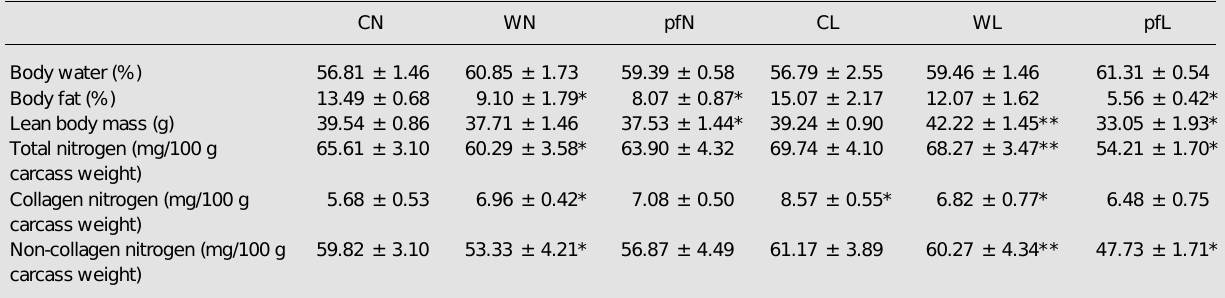
Table 2 - Body water content, body fat, lean body mass, total carcass nitrogen, and collagen and non-collagen nitrogen content of the pregnant groups